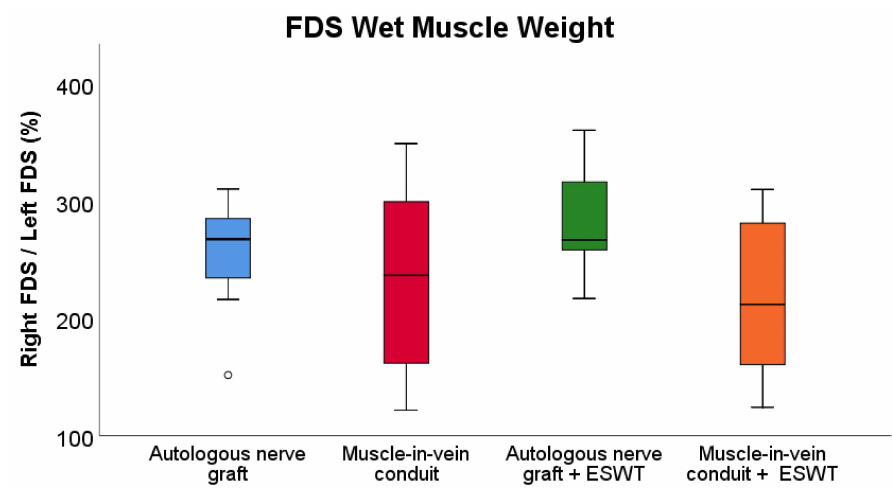
Figure 6. Comparison of the wet muscle weight ratio of the right and left flexor digitorum superficialis muscles at postoperative week 12 following bilateral resection and unilateral reconstruction of the right median nerve. Autologous nerve graft: n = 14; muscle-in-vein-conduit: n = 15, autologous nerve graft + ESWT: autologous nerve graft with postoperative extracorporeal shockwave therapy ( n = 15); muscle-in-vein-conduit + ESWT: muscle-in-vein conduit with postoperative extracorporeal shockwave therapy ( n = 11). Statistical analysis was performed with the nonparametric Kruskal– Wallis test and the Dunn–Bonferroni post hoc test. For subgroup analysis of identical reconstructive approaches, the Mann–Whitney U test was used. FDS: flexor digitorum superficialis muscle.